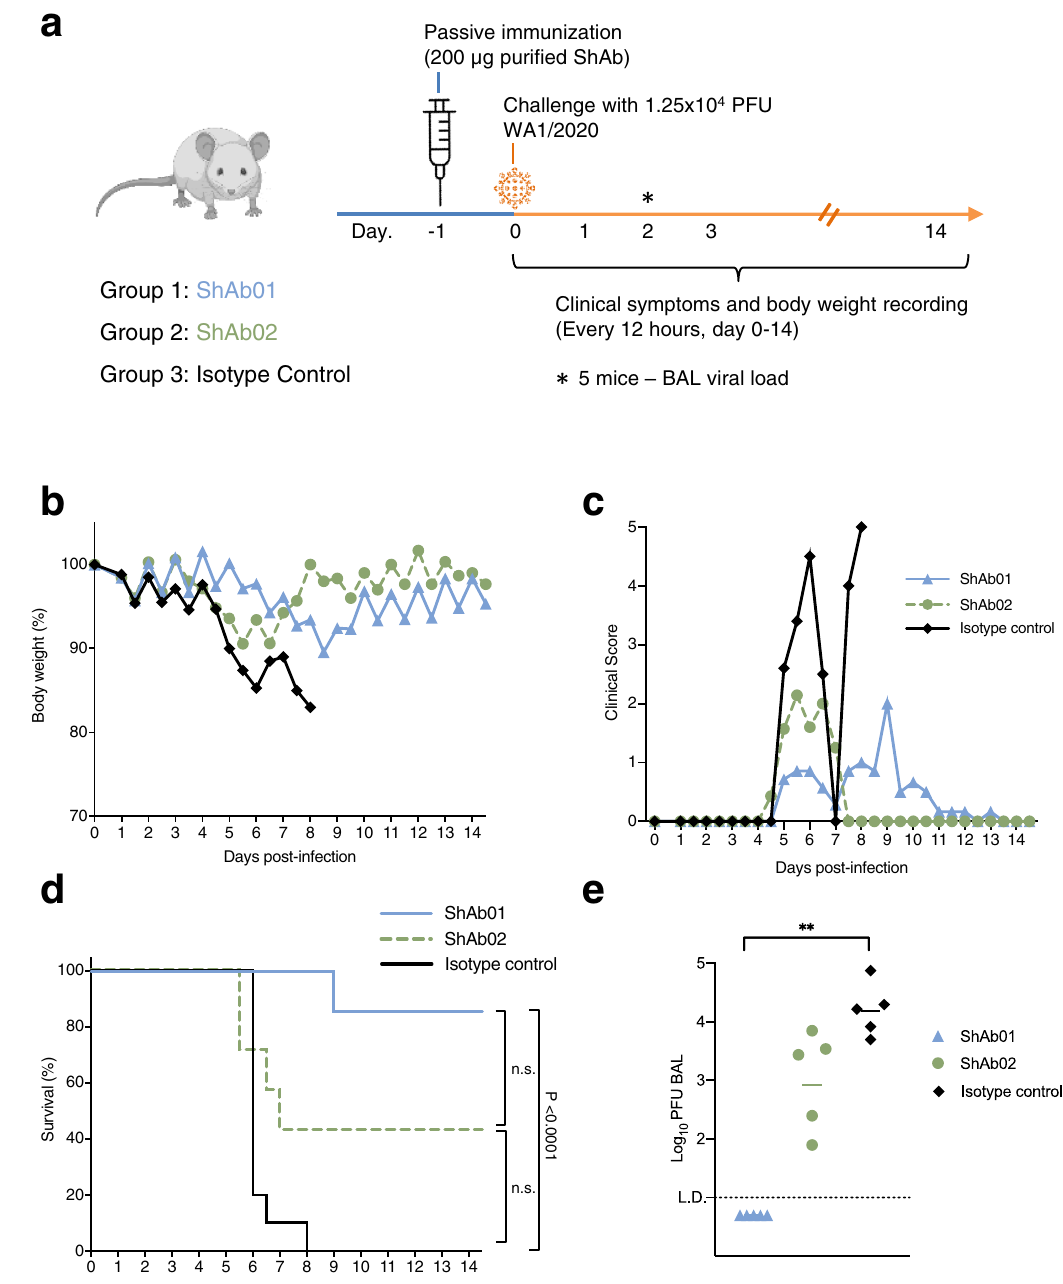
Fig. 3 | Passive immunization with ShAb01 and ShAb02 protect mice from SARS-CoV-2 challenge. a Schematic of K18-hACE2 mice SARS-CoV-2 challenge study. Mice ( n =13/group, 7 female, 6 male; 15/group for the isotype control, 8 female, 7 male) received an intraperitoneal injection of ShAb01 (blue), or ShAb02 (green), or IgG1 isotype control mAb (black), one day prior to challenge with 1.25×10 4 PFU of SARS-CoV-2 virus (WA-1/2020). A cohort of mice ( n =5/group) weresacri fi ced2dayspost-challengewiththeBAL fl uidanalyzedforviralload.The remaining mice ( n =8/group or 10 for the isotype control group) were assessed daily for weight and clinical symptoms. b Body weight measurements for K18- hACE2 mice. Percentage of initial weight is plotted. Isotype control mAb (black diamond), or ShAb01 (blue triangle) or ShAb02 (green circle). c Clinical score